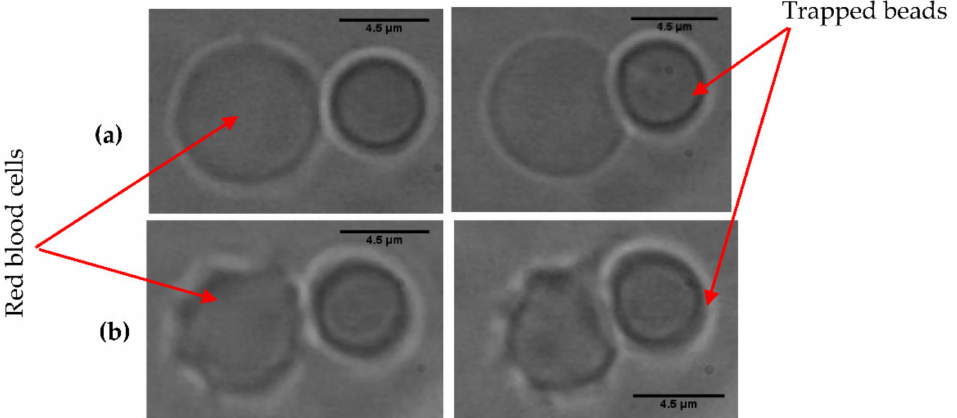
Figure 4. ( a ) Image of the interaction between the trapped bead and the spherical RBC in PBS solution with an osmolarity of 150 mOsm, ( b ) image of the interaction between the crenelated RBC and the bead in PBS solution with an osmolarity of 900 mOsm. Ten spherical RBCs and 10 crenelated RBCs were